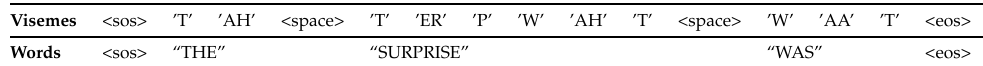
Table 2. A sequence of visemes and its corresponding word